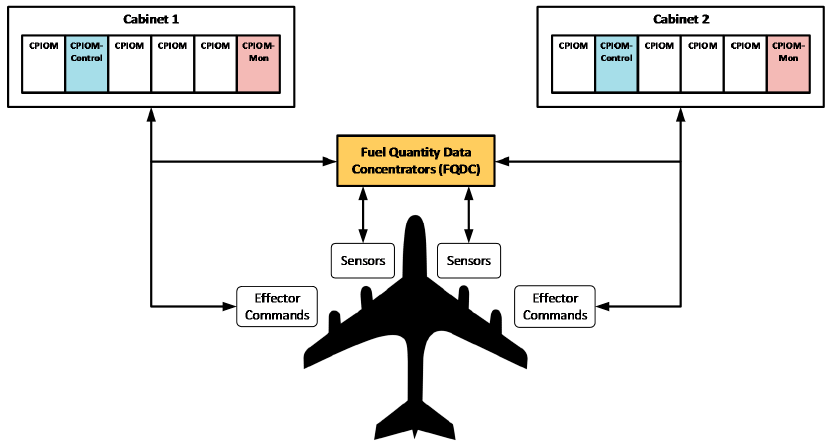
Figure 5. Fuel measurement and management platform (adapted view from [6]).